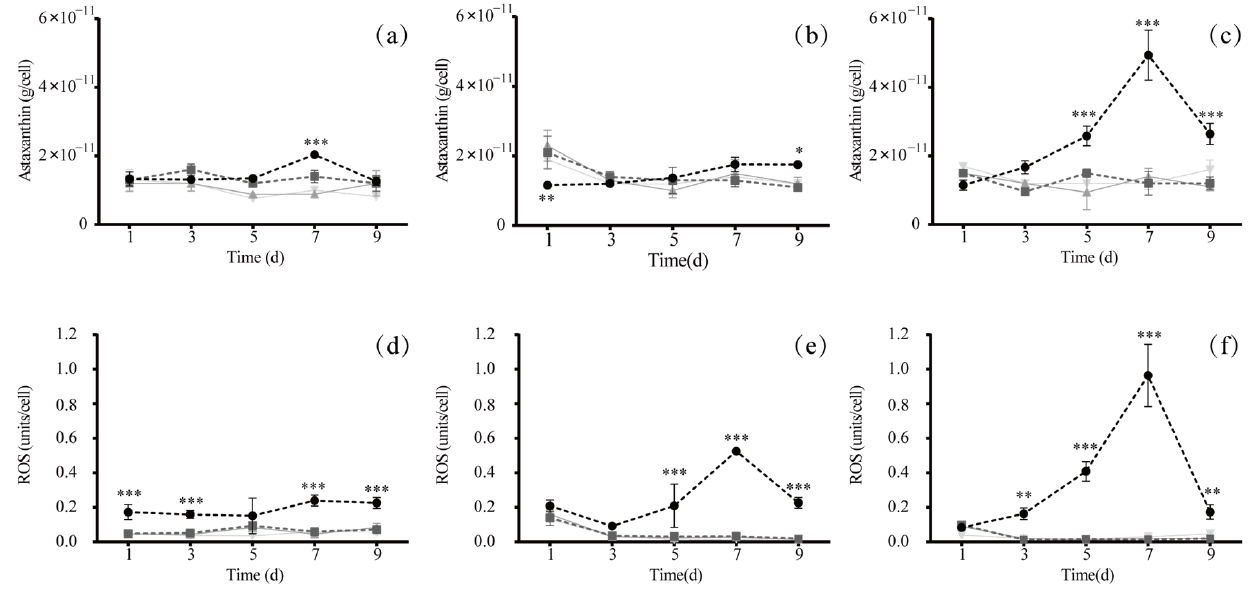
Figure 9. Astaxanthin curves of H. lacustris under light intensities of ( a ) 18 μ mol/m 2 ·s, LL; ( b ) 55 μ mol/m 2 ·s, ML; ( c ) 110 μ mol/m 2 ·s, HL. ROS curves of H. lacustris under light intensities of ( d ) 18 μ mol/m 2 ·s, LL; ( e ) 55 μ mol/m 2 ·s, ML; ( f ) 110 μ mol/m 2 ·s, HL. Continuous light (black circle), 2/2 s (black box), 2/2 h (gray triangle), and 6/6 h (gray inverted triangle). Error bars show the standard deviation for three replicates. Asterisks indicate statistically significant differences resulting from Student’s t -tests: * p < 0.05, ** p < 0.01, *** p < 0.001.